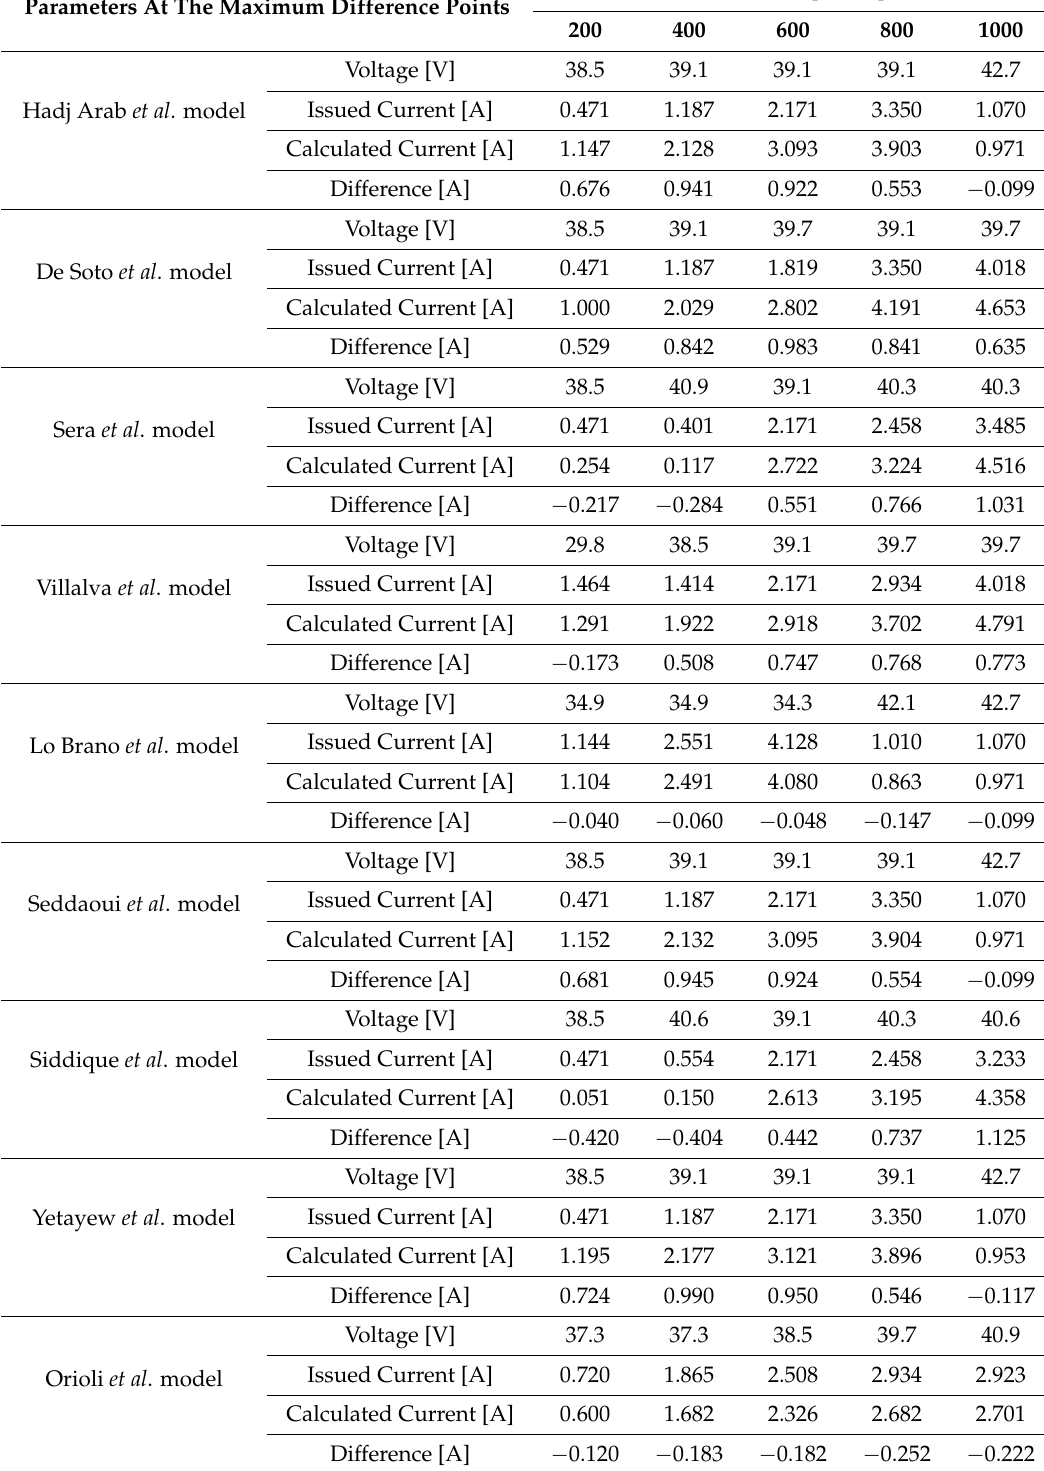
Table 8. Maximum current differences between the calculated and the issued I-V characteristics of Sanyo HIT-240 HDE4, at temperature T = 25 ˝